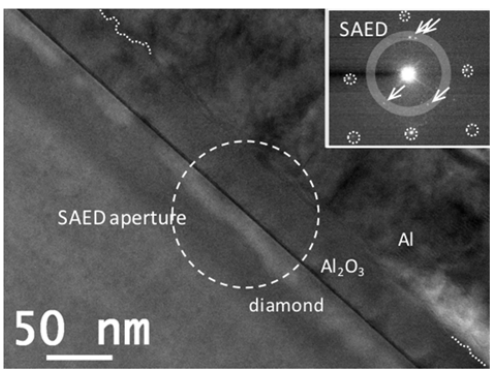
Figure 2. High ‐ resolution electron microscopy (HREM) micrograph of sample A, where the followings is observed: The alumina layer is polycrystalline; Non ‐ planar alumina top surface (dashed white line marks the top surface of the alumina in a specific area of the micrograph); and There is a thin layer of amorphous alumina between the diamond and the polycrystalline alumina area (identified by the white arrow).